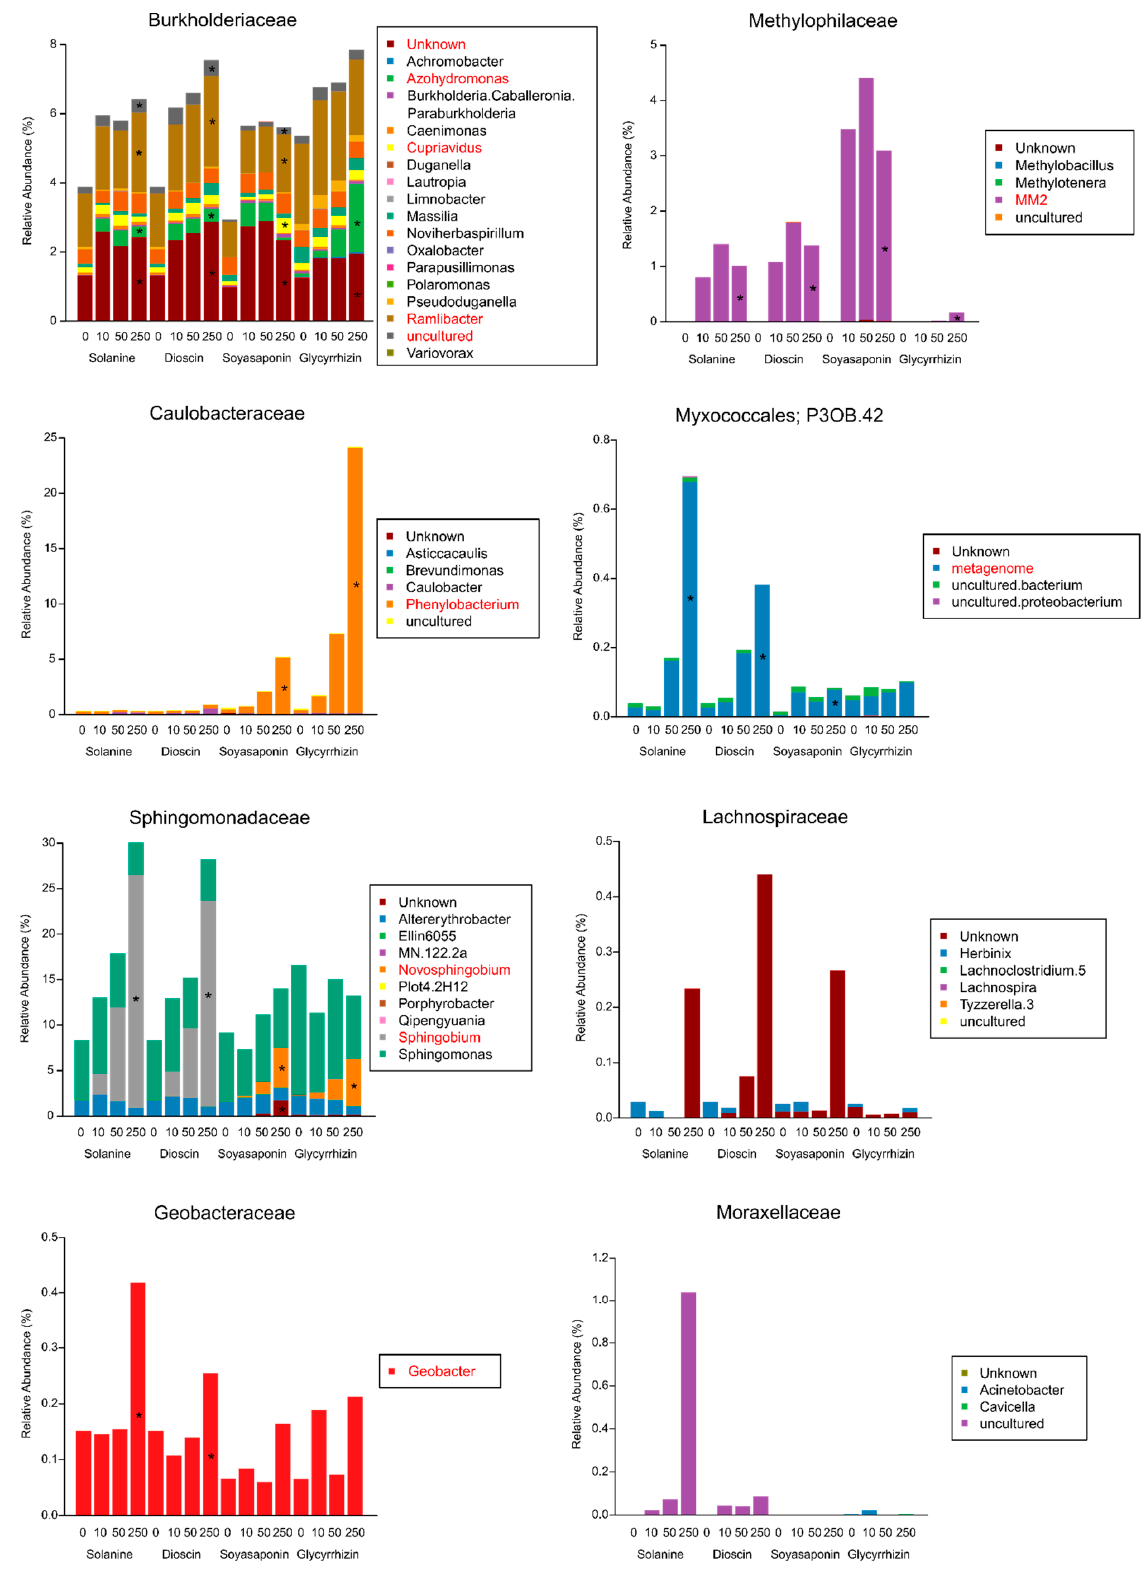
Figure 6. The mean relative abundances for the bacterial genera found in the representative families enriched in the soils treated with saponins, 10, 50, and 250 nmol (low, middle, and high concentrations) g soil − 1 ( n = 4). Asterisks and red letters indicate significantly enriched genera (the mean of all samples >0.1%) in soils treated with saponins, 250 nmol (high concentrations) g soil − 1 using the LEfSe method (an adjusted p -value <